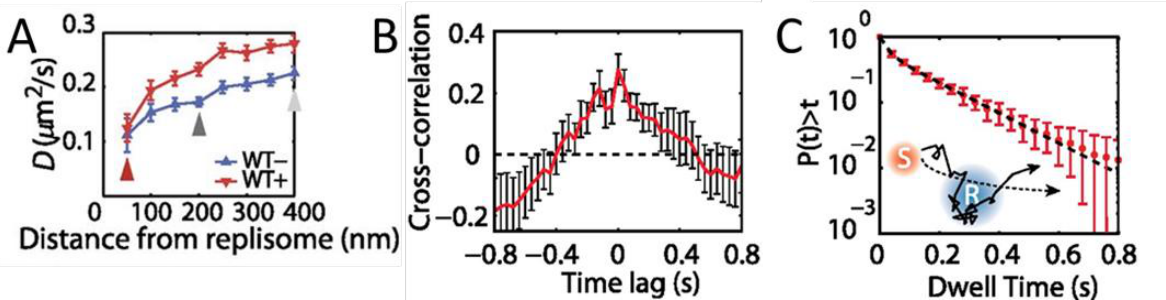
FIGURE 4: MutS dynamics in B. subtilis cells. (A) Effective diffusion coefficients, D , of MutS-PAmCherry as a function of separation dis- tance from the nearest replisome. Error bars indicate 95% confidence interval. WT+ indicates cells that have been treated with the 2-AP mutagen. (B) Cross-correlation between the separation between MutS and the center of DnaX cluster and the instantaneous speed of MutS. (C) Cumulative probability distribution of the time, t , that MutS (red “S”) spends within the same replisome region (blue “R”). Re- produced from Liao et al. PNAS 2015